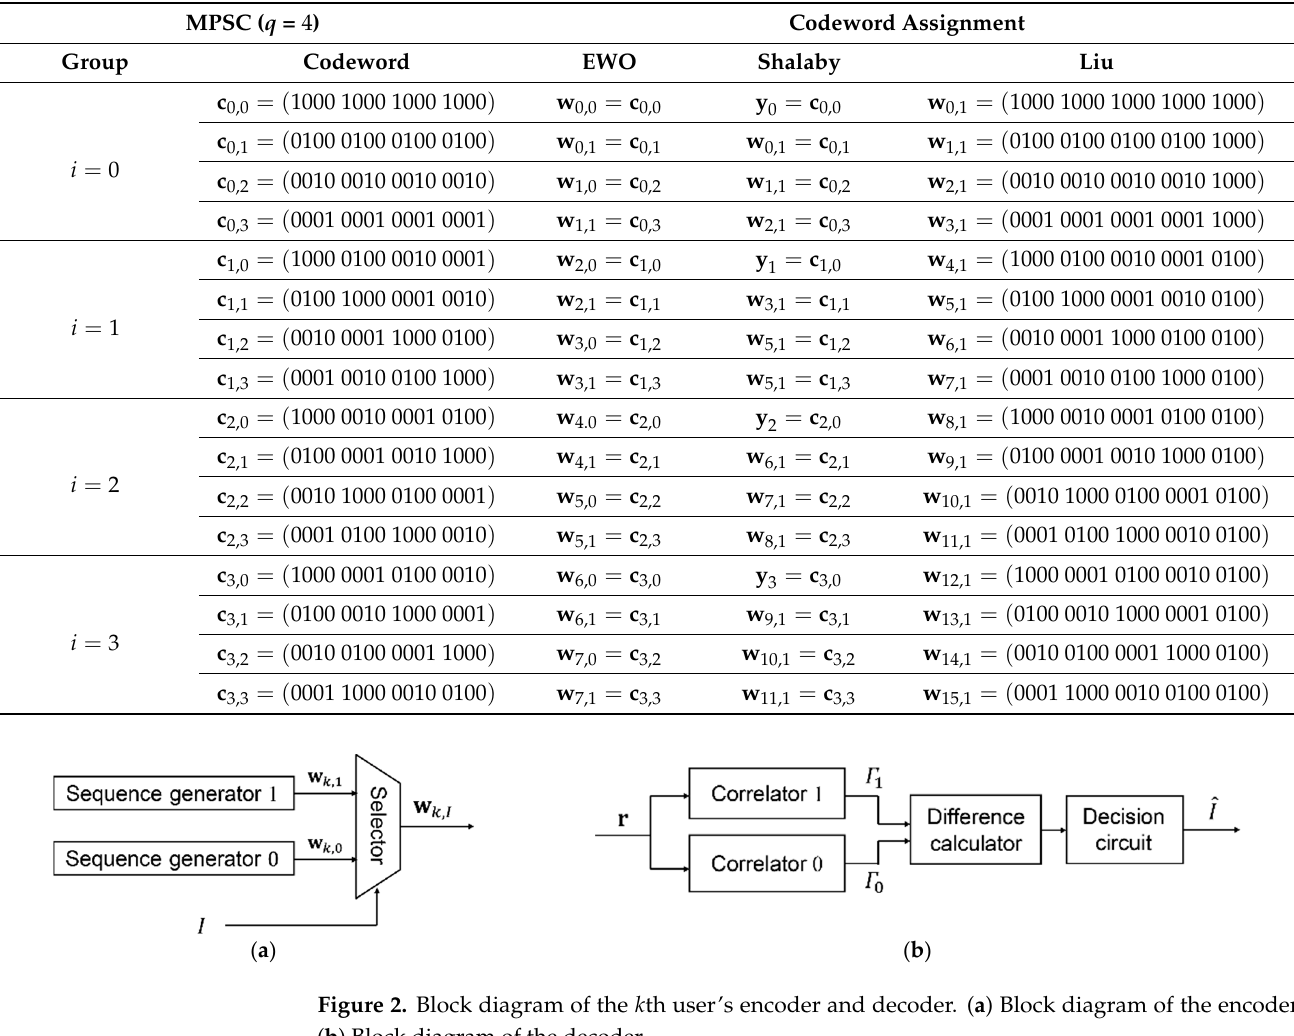
Table 2. Codeword assignment for MPSC ( q = 4).